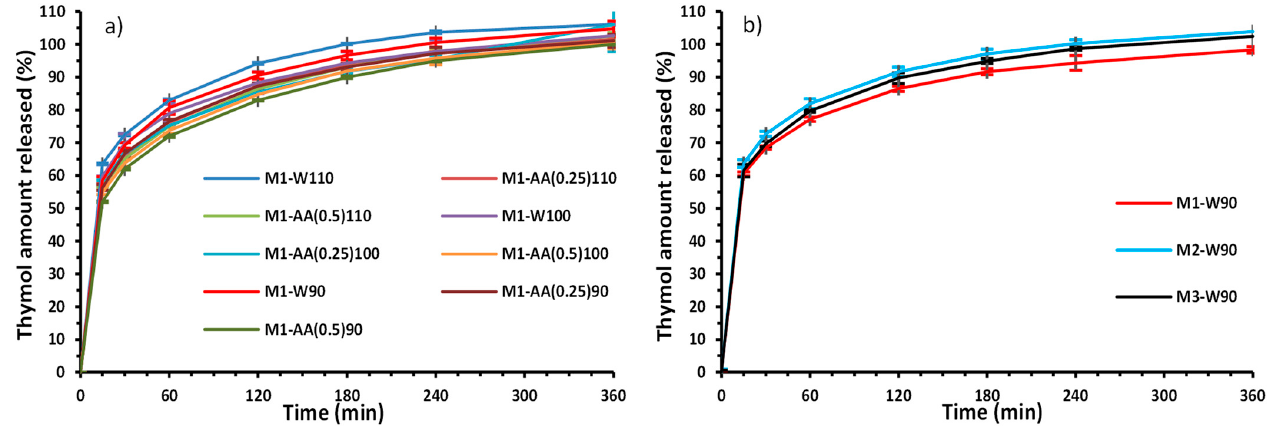
Figure 2. ( a ) Dissolution profiles of the M1 uncoated pellets differing in type and amount of wetting liquids (pH 6.8, 1% of polysorbate 80); ( b ) dissolution profiles of uncoated pellets differing in preparation method (pH 6.8, 1% polysorbate). Table 3. Similarity factor analysis of uncoated